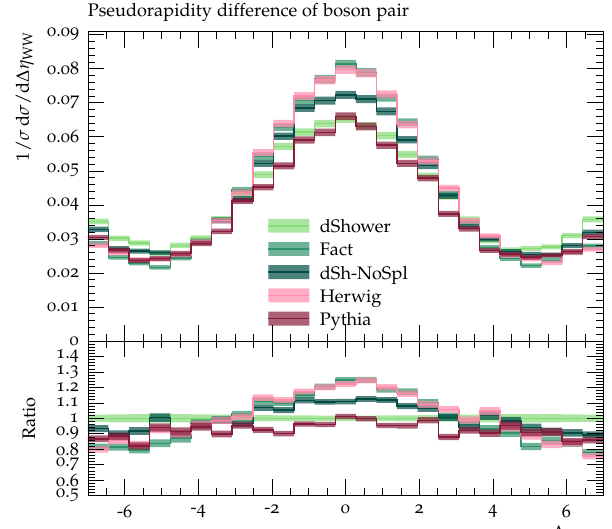
Figure 12 . Di(cid:11)erence between the pseudorapidities of the two W bosons. The setup dShower is the reference in the ratio plot.